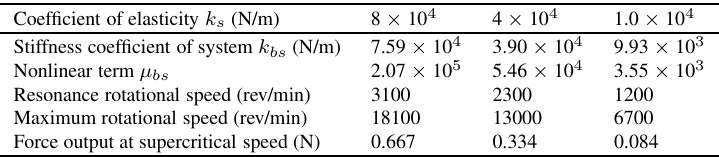
Table 2 Performance of CMWA with different soft suspension support in